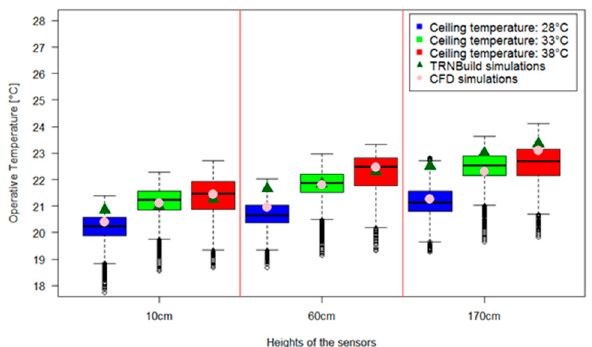
Figure 7. Comparisons between the simulation results of the TRNBuild as well as CFD and the experimental data related to three radiant ceiling temperatures and three heights of sensors (10 cm, 60 cm, and 170 cm). The experimental data are shown in box plots, whereas the TRNBuild and CFD results are shown with triangle and circle symbols, respectively.